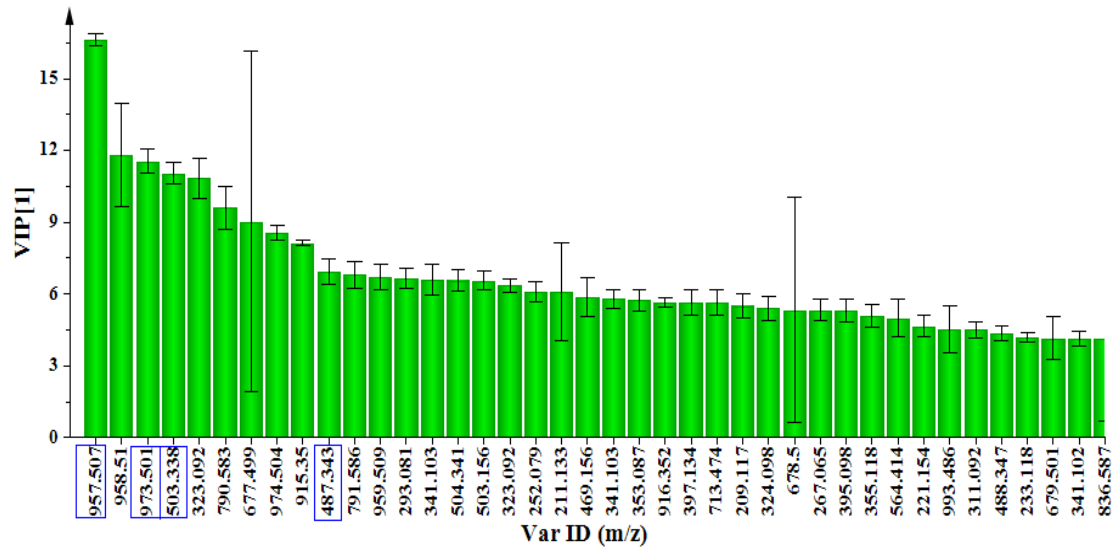
Figure 3. A variable importance in projection (VIP) plot of day 4 samples. The VIP plot indicates that the mass ions m/z 487.3426, 503.3382, 957.5069 and 973.5014 were accountable for the significant separation in the model as their VIP scores were significantly greater than